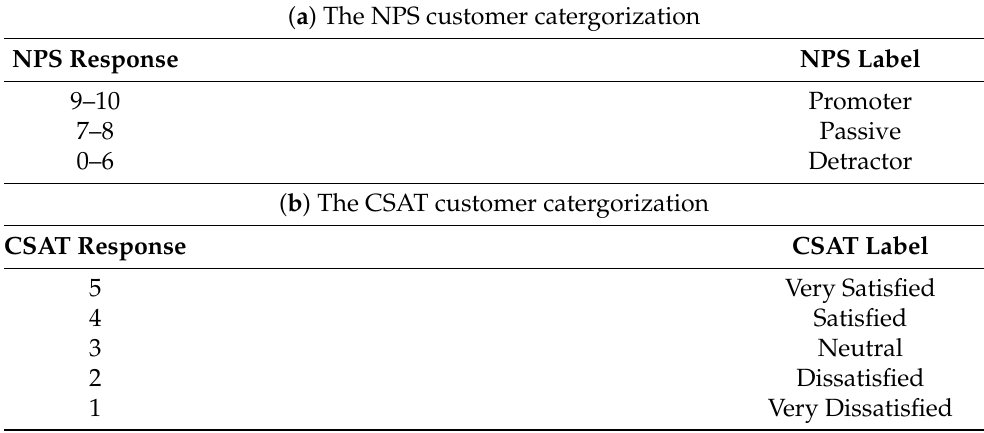
Table 1. The two most widely used customer